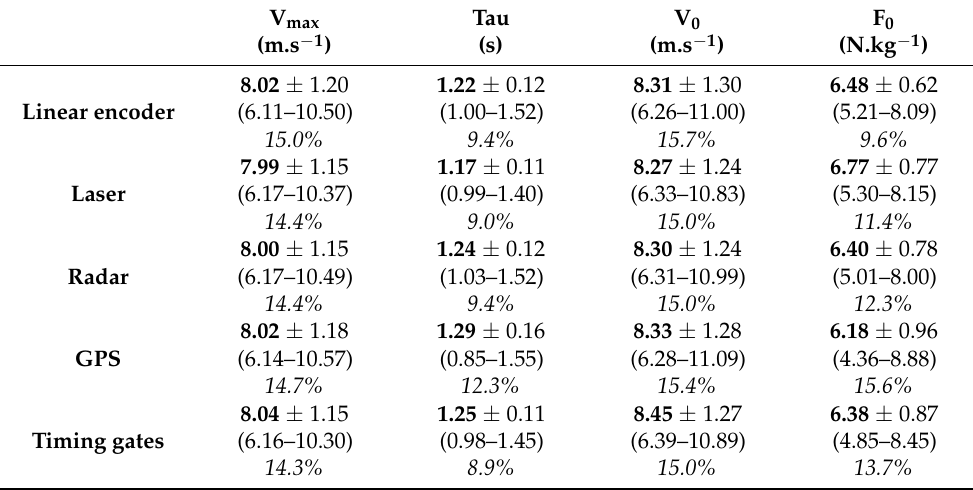
Table 1. Main mechanical variables computed from position or velocity data collected during 40 m sprints for all participants and trials (n = 36) using the five systems compared. Values are mean (in bold) ± SD, (min–max). Numbers in italic indicate the inter-subjects’ coefficient of variation (%) for maximal velocity (V max ), acceleration time constant (Tau), and theoretical maxima of the force–velocity relationship (F 0 and V 0 ).